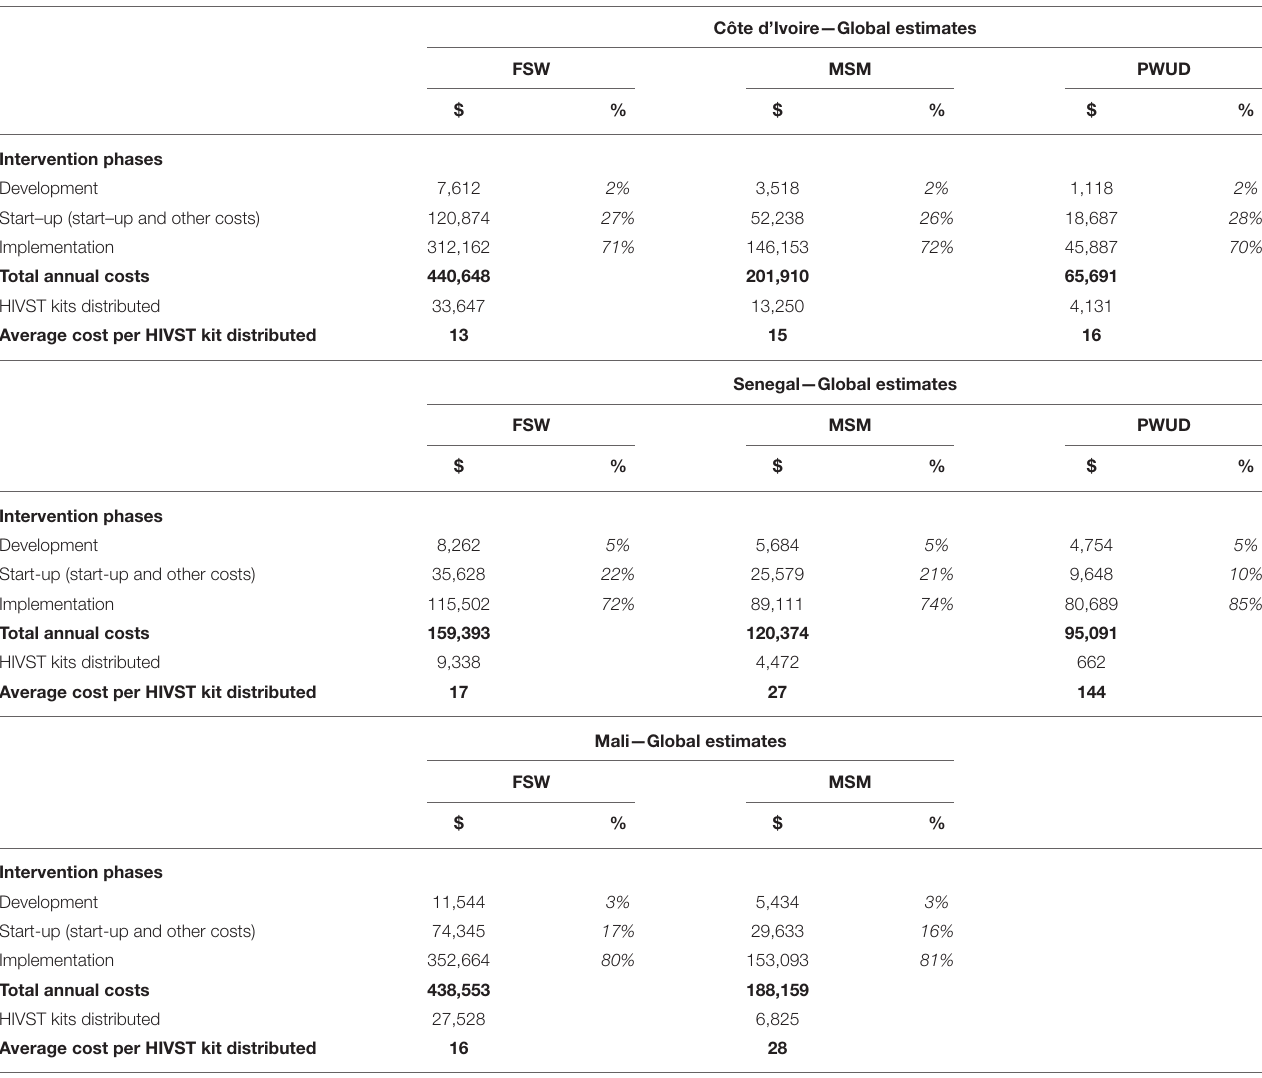
Côte d’Ivoire—Global